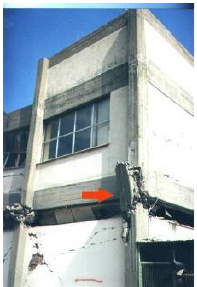
Figure 4. Damaged short columns from the interaction of unreinforced masonry infills (UMI), built within the bay of an RC frame structure, with the adjacent RC columns.